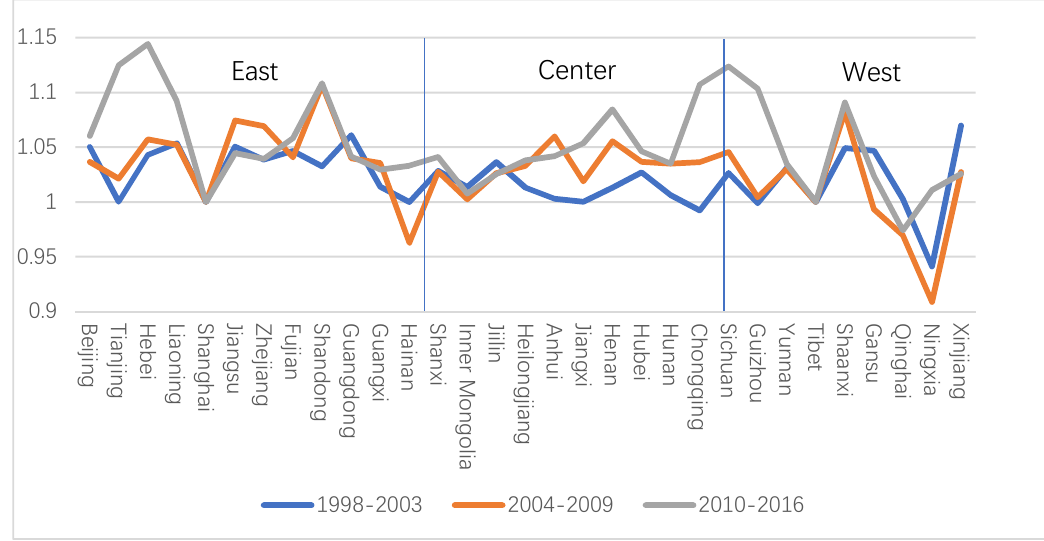
Figure 4. GTFPI in three periods in each province.